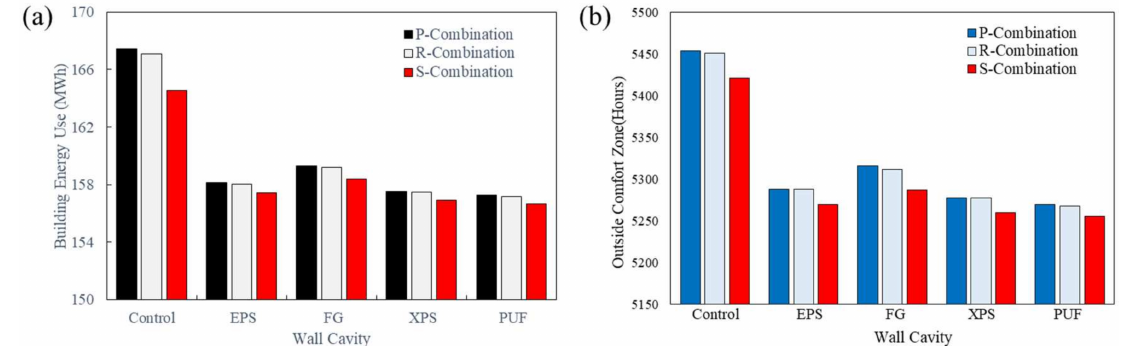
Figure 4. ( a ) Insulation effect on 3DPC building energy use; ( b ) Effect of insulation on 3DPC thermal comfort